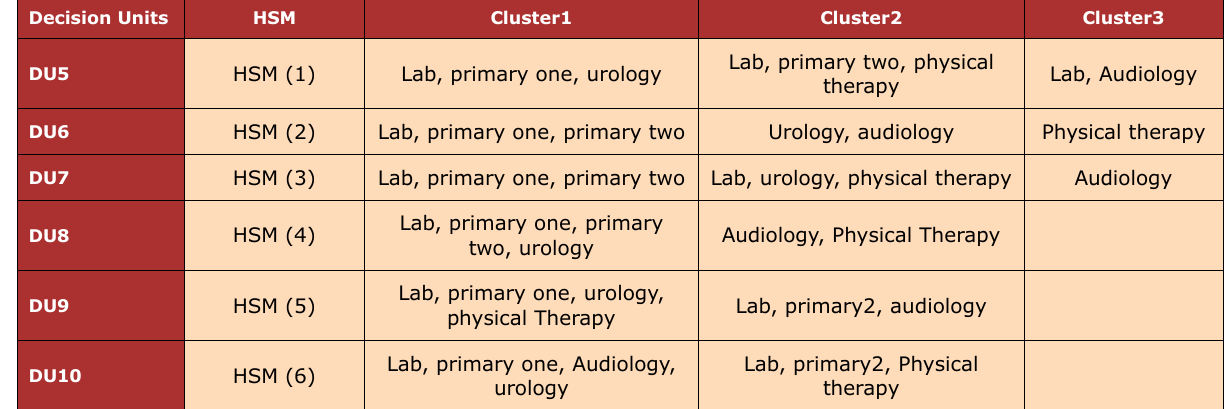
Table 3. Configurations with hybrid scheduling